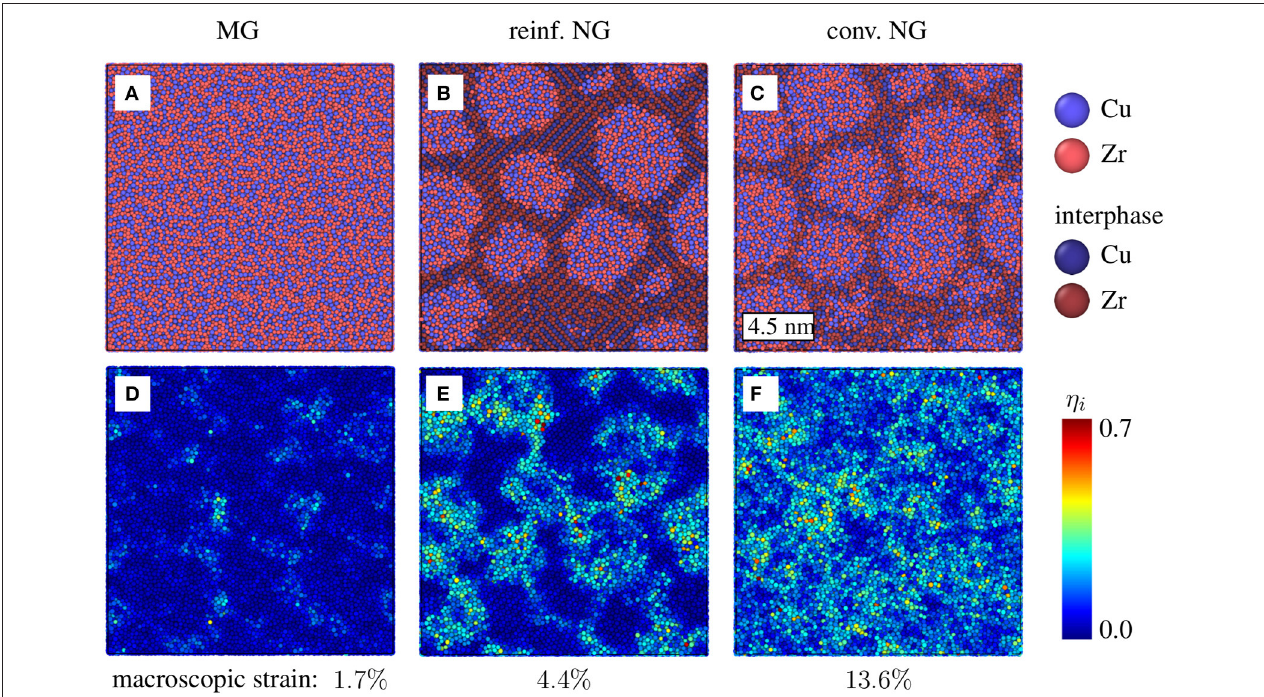
FIGURE 3 | Snapshots of the atomic configurations of the (A,D) homogeneous glass, (B,E) reinforced NG, (C,F) conventional NG samples after 40 ns of creep at 550 K , color coded according to their particle type (top row) and according to the local von Mises strain (bottom